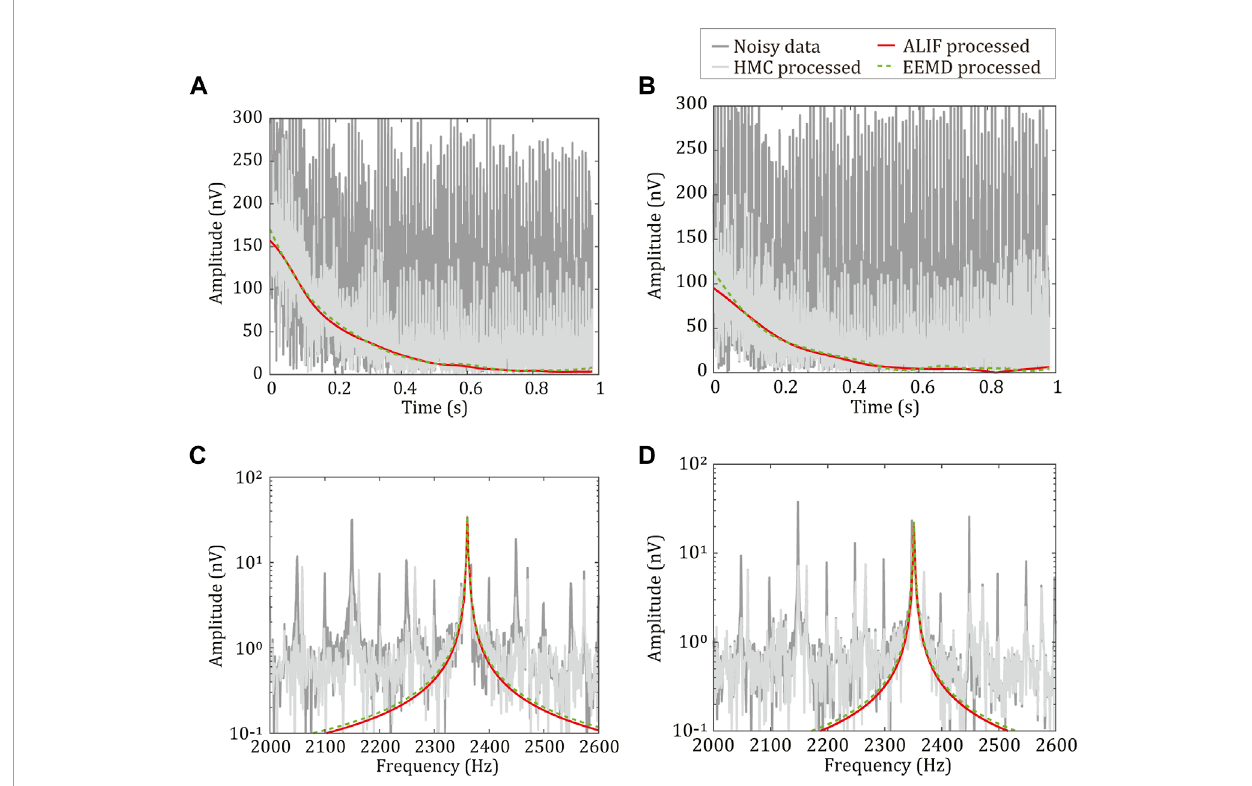
FIGURE 9 Results of field data before and after processing. In (A) and (C) , Larmor frequency is 2,360 Hz and relaxation time is 200 ms. In (B) and (D) , Larmor frequency is 2,351 Hz and relaxation time is 200 ms. Dark gray lines represent the original signal envelope, light gray lines represent the signal envelope after HMC processing, green lines represent the signal envelope after EEMD algorithm processing, and red lines represent the signal envelope after ALIF algorithm processing.